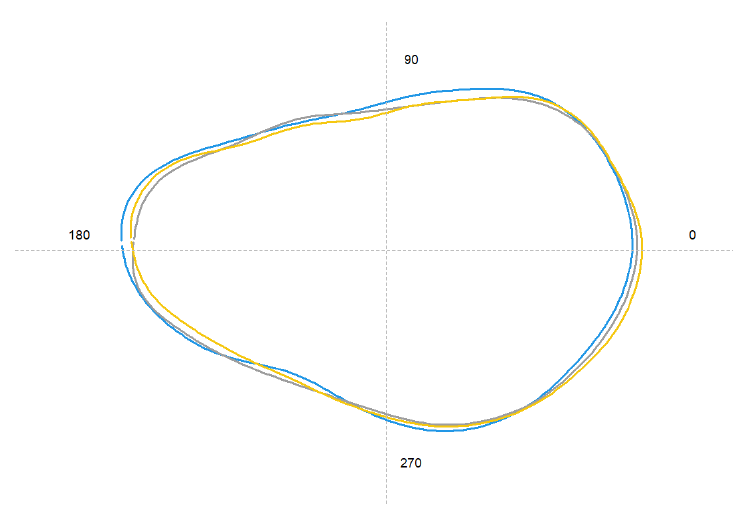
Figure 4. Average shape of otolith contour extracted from elliptical Fourier descriptors of the three